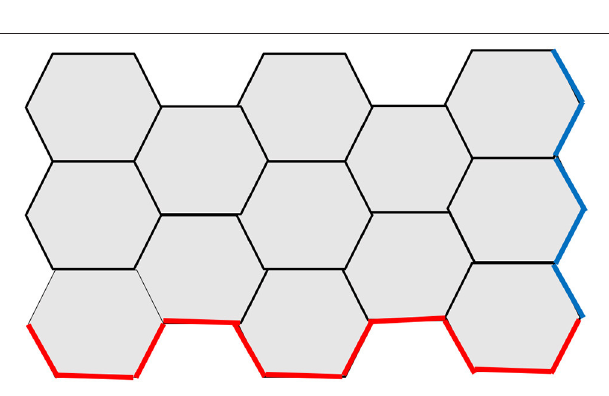
FIGURE 3 | Armchair (red) and zigzag (blue) edges in monolayer graphene.